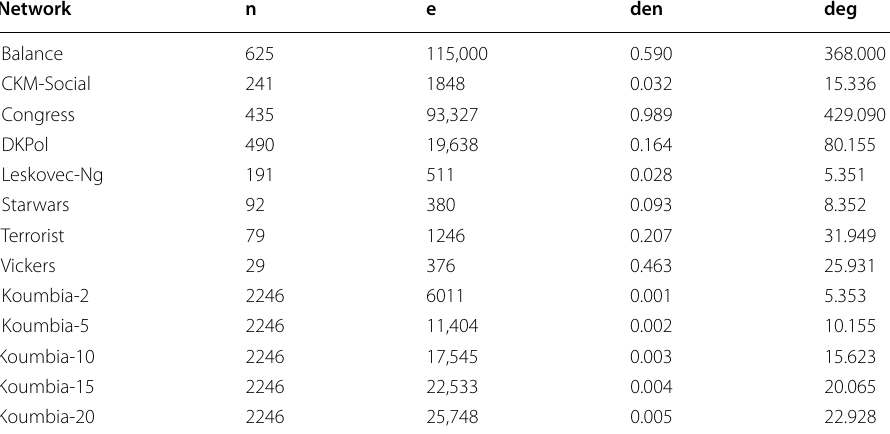
Table 3 Summary of structural characteristics of the flattened (monoplex) versions of the evaluation networks: number of nodes (n), number of edges (e), average density (den), and